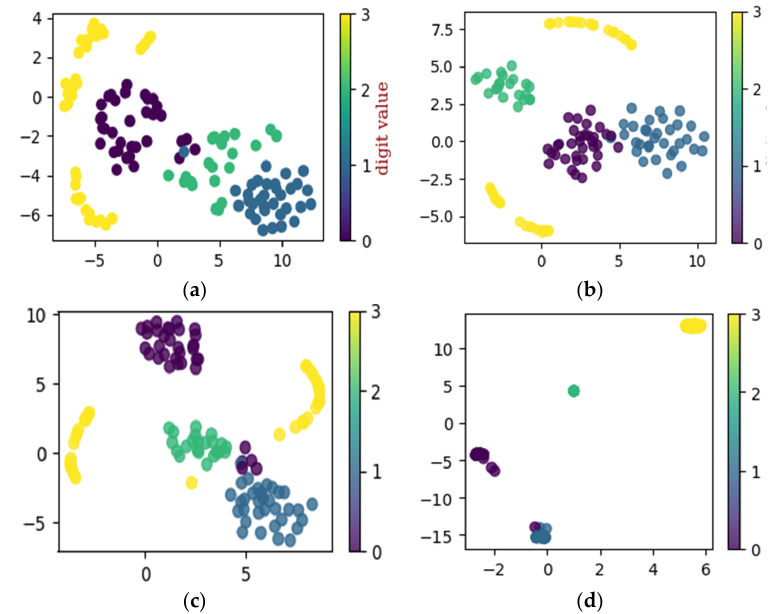
Figure 16. The t-SNE for self-learning ability utilizing dataset configuration D: ( a ) raw data, ( b ) con- volution layer, ( c ) convolution layer, and ( d ) final classification.